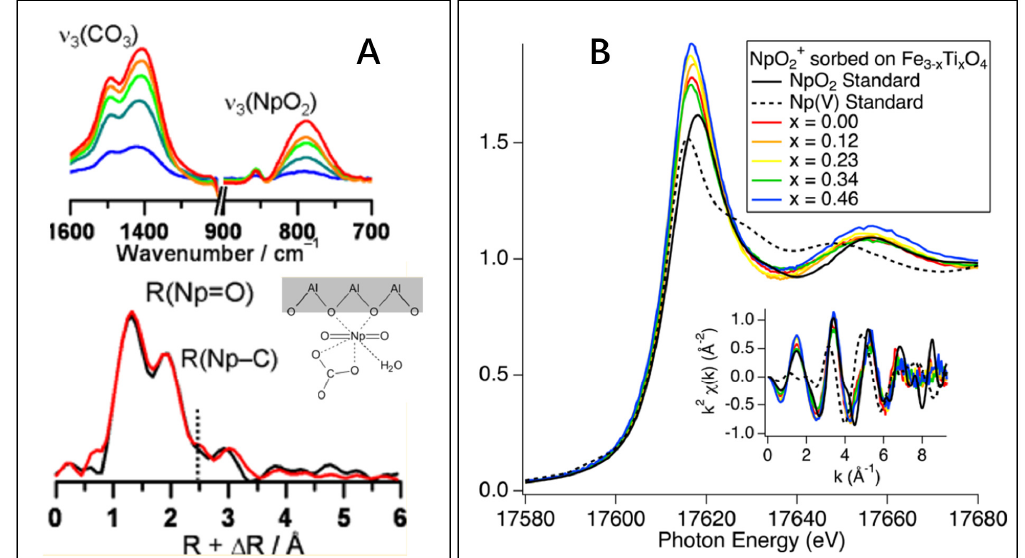
Figure 4. ( A ): The Np IR and EXAFS spectra and the microstructure of Np bidentate surface complexes on Al(OH) 3 surfaces. Reorganized from TOC. Reprinted with permission from ref. [30]. Copyright 2021 Amrican Chemical Society; ( B ): normalized X-ray absorption spectra from samples, NpO 2 and Np(V)(aq) standards and k-space EXAFS (inset). The similarity of the titanomagnetite samples’ absorption edges to the Np(IV) standard, note the lack of “neptunyl” shoulder, and lack of Np-Np scattering peak at 3.7 Å, this shows a reduction of Np(V) without precipitation Reprinted with permission from ref. [31]. Copyright 2021 Amrican Chemical Society.